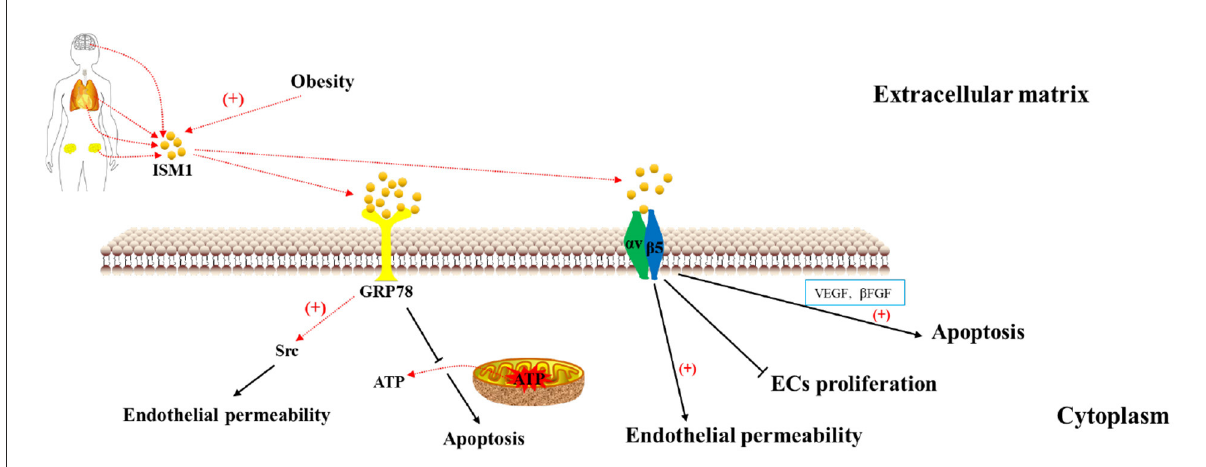
FIGURE2 ISM1 binds to GRP78 and α v β 5 integrin to induce apoptosis and promote endothelial